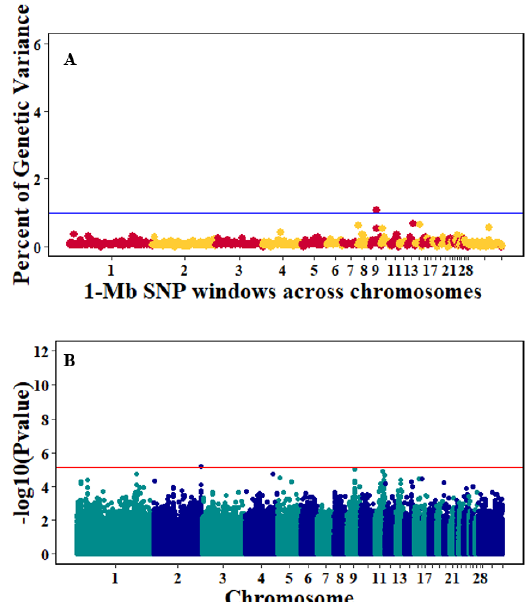
Figure 5. Manhattan plots showing the genome-wide association results for antibody levels at 10 dpi using Bayes-B and single-SNP analyses. ( A ) Bayes-B results show the percent of genetic variance explained by 1-Megabase (1-Mb) nonoverlapping windows of SNPs across chromosomes. ( B ) Single-SNP results show the − log 10 ( p -value) of ordered SNPs across the chromosomes. The blue and red lines indicate genome-wide significance at 1% genetic variance and 20% suggestive adjusted Bonferroni correction, respectively.